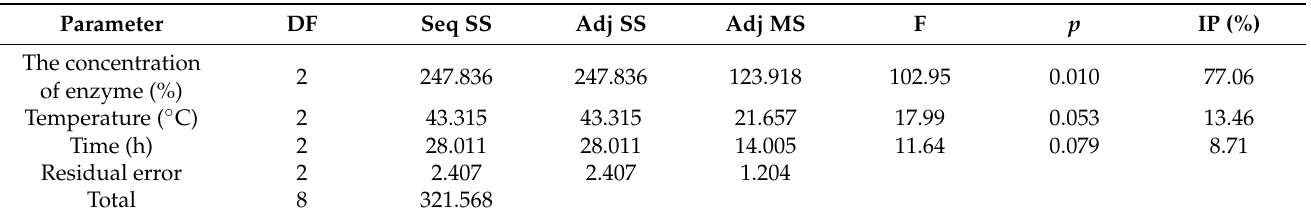
Table 5. The analysis of variance (ANOVA) for the DH/(IB) obtained for the L9 (33) orthogonal